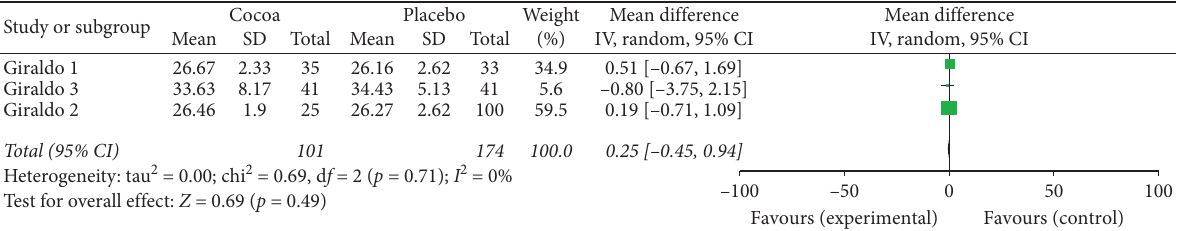
Figure 6: Meta-analysis of the effect of cocoa consumption on body mass index (BMI) as compared with placebo. The sizes of the data markers indicate the weight of each study in the analysis. IV: inverse